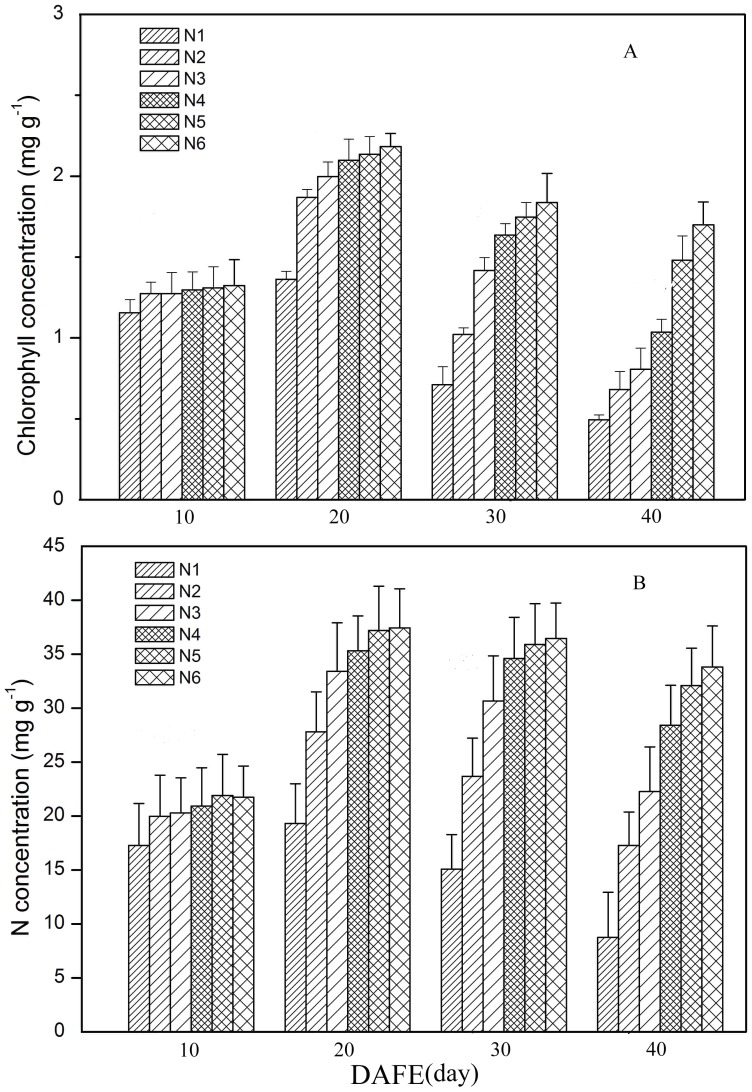
Temporal dynamics of chlorophyll concentration (based on per - unit fresh weight) and N concentration (based on per - unit dry weight) of individual leaves under six N application rates.N1 to N6 are the same as in the legend in Fig. 1.